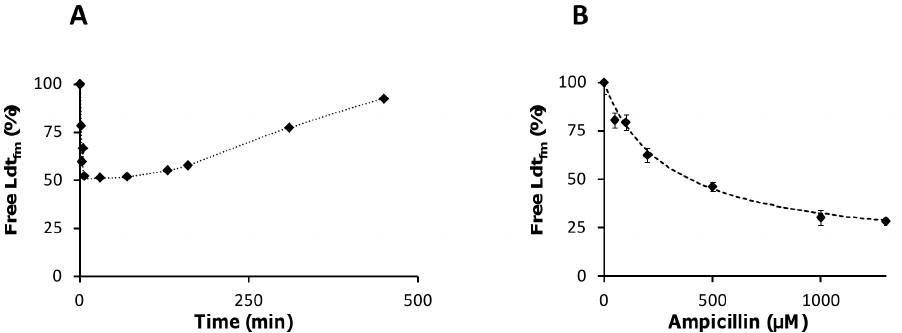
Figure 4. Determination of ampicillin-free Ldt fm using rapid inactivation by imipenem. (A) Ldt fm (20 m M) was incubated with ampicillin (200 m M) for indicated time and imipenem was used to determine the concentration of free enzyme by using stopped-flow spectrophotometry at 299 nm. The concentration of free Ldt fm reached a plateau revealing equilibrium between the various enzyme forms. The concentration of free Ldt fm slowly increased after 100 min due to a decrease in ampicillin concentration. (B) Concentration of free Ldt fm at equilibrium as a function of ampicillin concentration. Data are mean 6 SD of 3 experiments.